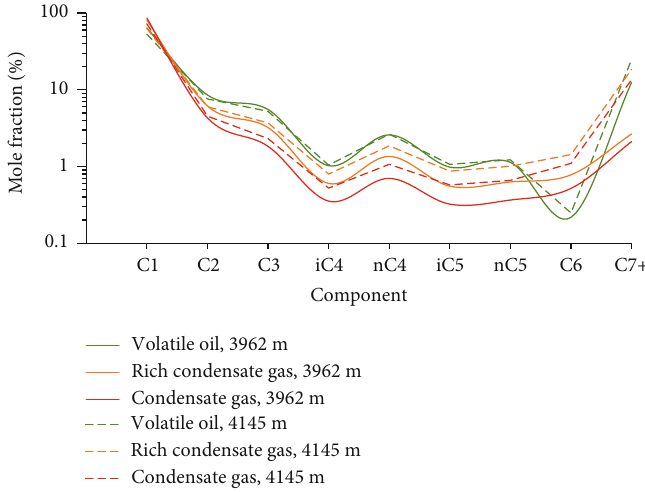
/C Figure 3: C 1 7+ contents varying with depth for di